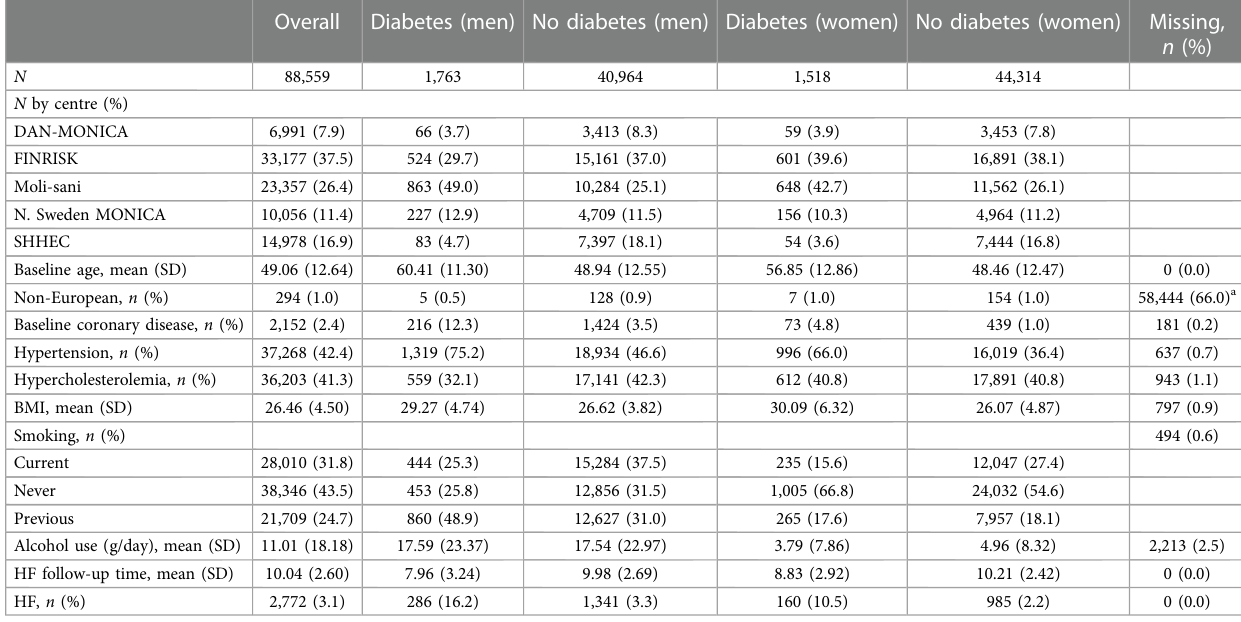
TABLE 1 Baseline characteristics and HF follow-up of the